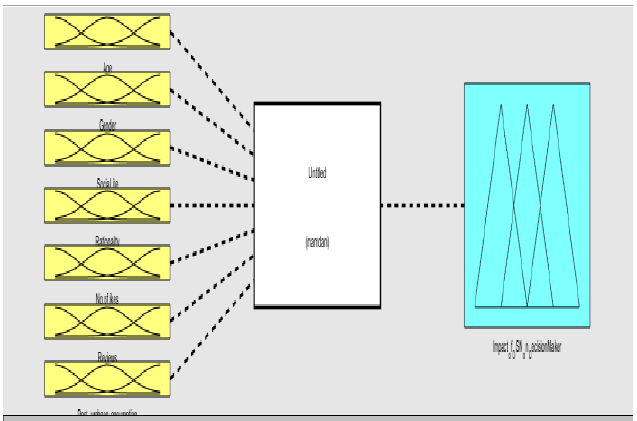
Figure 8. Fuzzy model